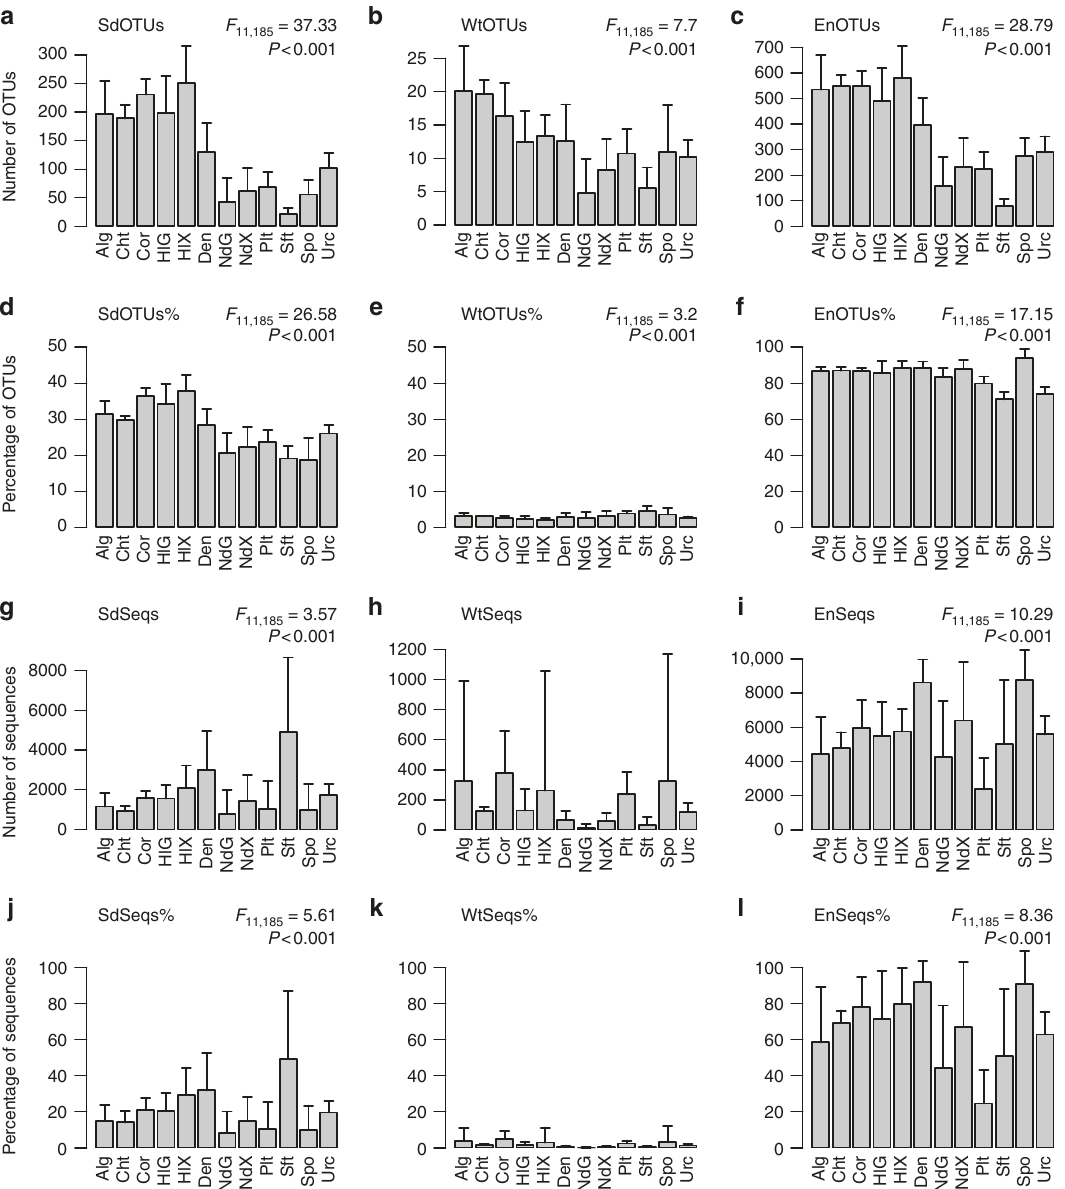
Fig. 6 Mean counts and percentages of sediment, seawater and environmental OTUs in selected hosts. Error bars represent a single standard deviation. Codes on the x -axis represent algae (Alg), chitons (Cht), stony corals (Cor), sea cucumber gut (HlG), sea cucumber mantle (HlX), sponge denizens (Den), nudibranch gut (NdG), nudibranch mantle (NdX), fl atworms (Plt), soft corals (Sft), sponges (Spo) and sea urchins (Urc). a Number of OTUs 100 shared with sediment only (SdOTUs), b number of OTUs 100 shared with seawater only (WtOTUs), c number of OTUs 100 shared with sediment and/or seawater (EnOTUs), d percentage of OTUs 100 shared with sediment only (SdOTUs%), e percentage of OTUs 100 shared with seawater only (WtOTUs%), f percentage of OTUs 100 shared with sediment and/or seawater (EnOTUs%), g number of sequences shared with sediment only (SdSeqs), h number of sequences shared with seawater only (WtSeqs), i number of sequences shared with sediment and/or seawater only (EnSeqs), j percentage of sequences shared with sediment only (SdSeqs%), k percentage of sequences shared with seawater only (WtSeqs%) and l percentage of sequences shared with sediment and/or seawater (EnSeqs%). Results of the GLM analyses are presented in the top right of the sub fi gures when signi fi cant. Source data are provided as a Source Data fi